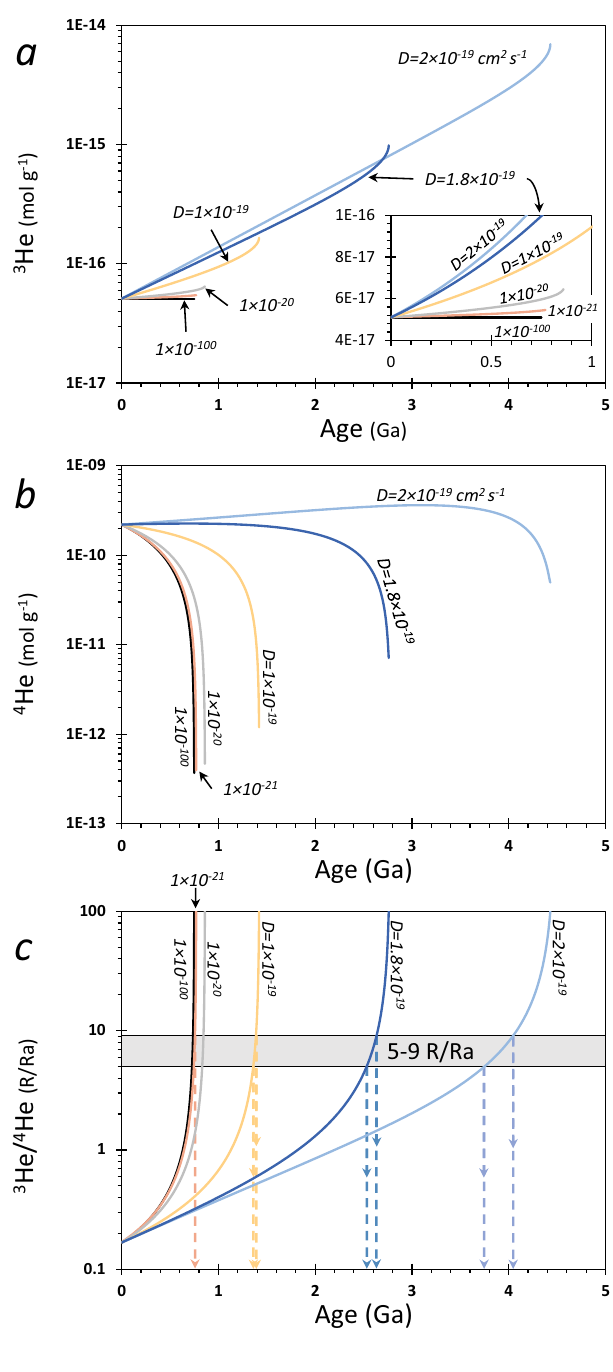
diamond ’ s edge (i.e., for a diamond with r = 2.5 mm, there is <250 µm of diffusion in 1 Ga if D < 10 − 21 and <750 µm of diffusion in 1 and the evolving 3 He/ 4 He ratio within the diamond. For example, 5%, and 9%, and 5%, 7%, and 13%, respectively, and the change in 3